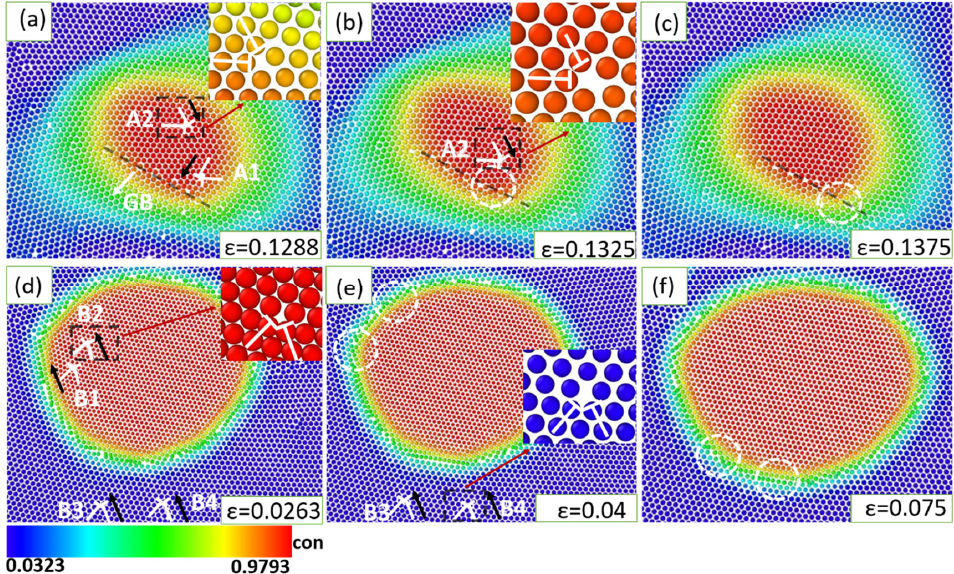
Figure 3. The dislocation dynamics around the deformed precipitate at different lattice misfits: ( a – c ) f = 4.3% ( d – f ) f = 19.3%. Note that the black arrows mark the moving directions of dislocation, the white circles are signs, the red arrows are the indicators.